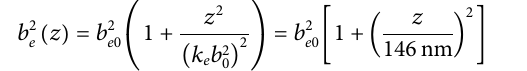
Frontiers in Physics |